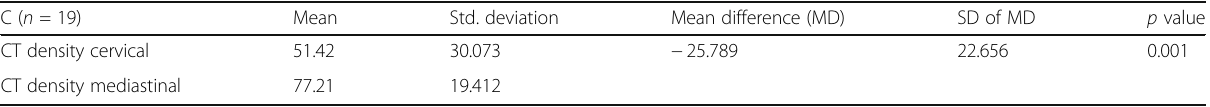
Table 2 Comparison of CT densities of cervical & mediastinal parts of thymus in 19 post-contrast CTs by Paired t test C ( n = 19) Mean Std. deviation Mean difference (MD) SD of MD p value CT density